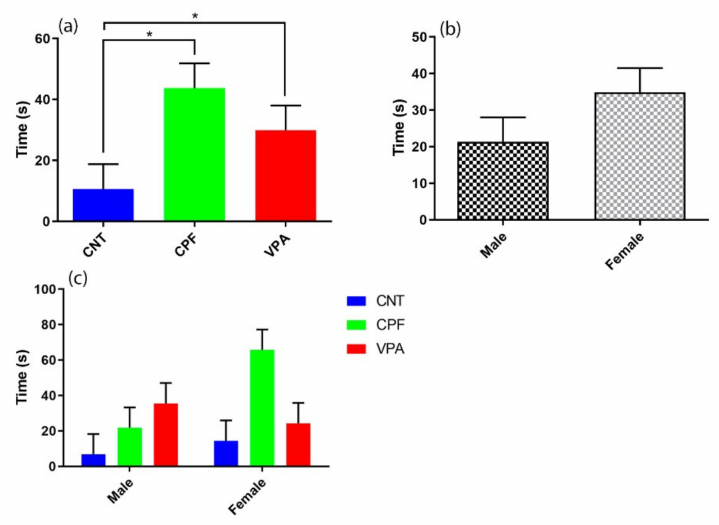
Figure 3. Latency to the first call (n = 42): ( a ) There were di ff erences according to treatment, with both CPF (n = 14) and VPA (n = 14) groups di ff ering significantly from CNT (n = 14). ( b ) There were no significant di ff erences according to sex (male n = 21; female n = 21). ( c ) The Treatment * Sex interaction was not significant, although there is a strong tendency for CPF females to take more time to emit their first call in comparison with the other groups (CNT male n = 7; CNT female n = 7; CPF male n = 7; CPF female n = 7; VPA male n = 7; VPA female n =